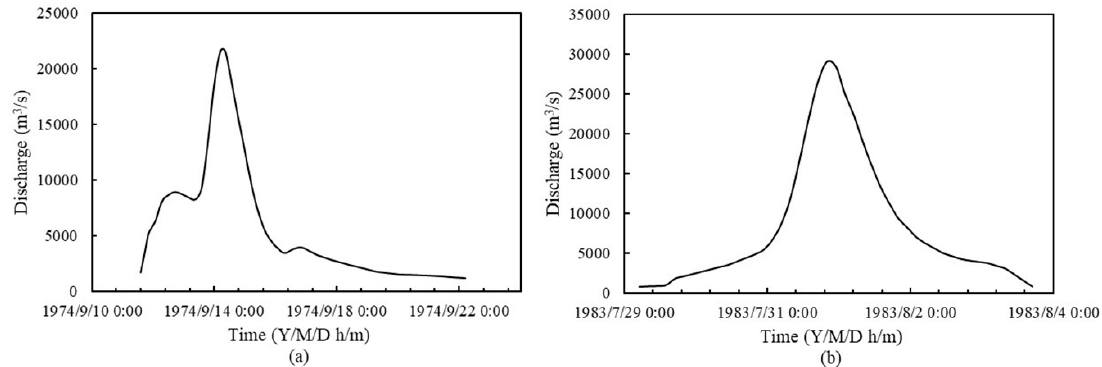
Figure 2. The hydrograph of the 1974 typical flood and the 1983 largest flood. ( a ) The hydrograph of the typical flood in 1974; and ( b ) The hydrograph of the largest flood in 1983. Table 2. Information for the reservoirs in the study area.